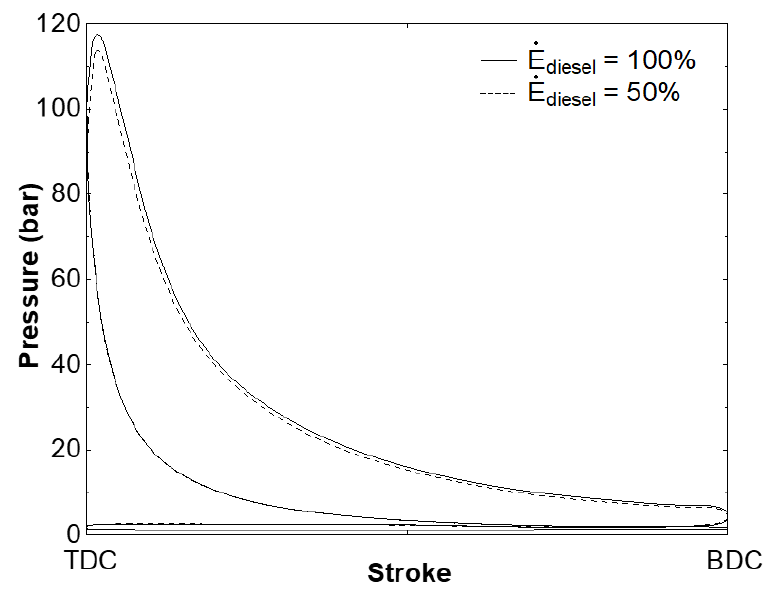
Figure 10. In-cylinder pressure under 100% and 50% power contribution from diesel fuel.